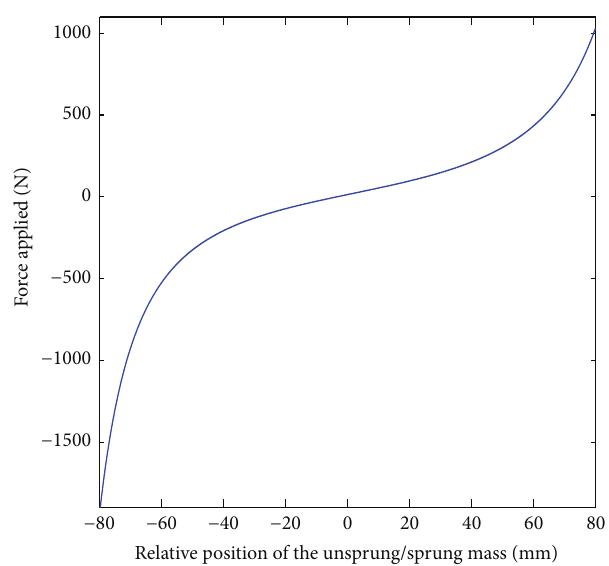
Figure 10: Force applied in wheel side versus different relative position of the unsprung